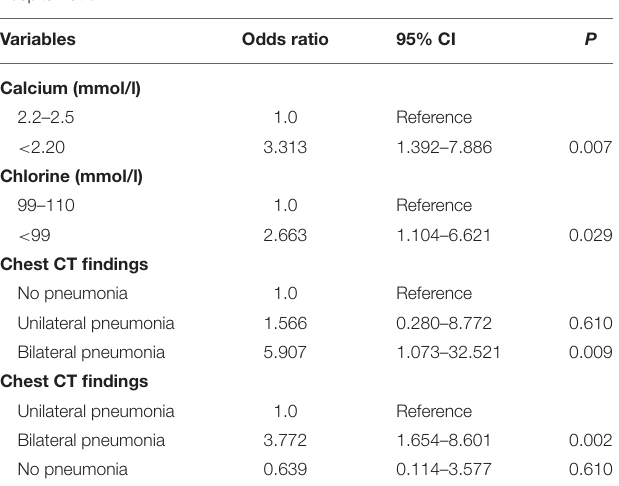
TABLE 3 | Multivariable analysis of risk factors associated with long-term hospitalization.